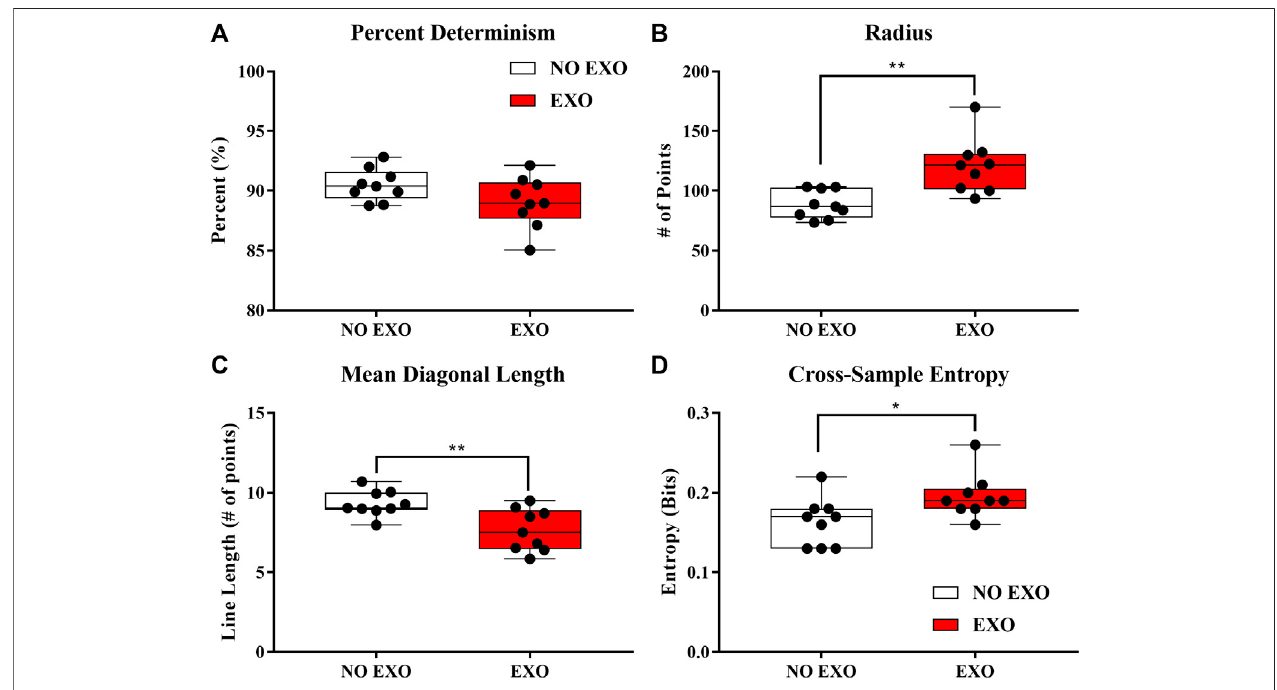
FIGURE 6 | (A – D) Box and whisker plots showing inter-quartile ranges. (A) shows the main cRQA variables that were analyzed. (B) shows the entropy value from cSE. Each dot represents one participant. Signi fi cant differences between the EXO and the NO EXO groups are shown. p p < 0.05 , pp p < 0.01 , and ppp p < 0.001 .